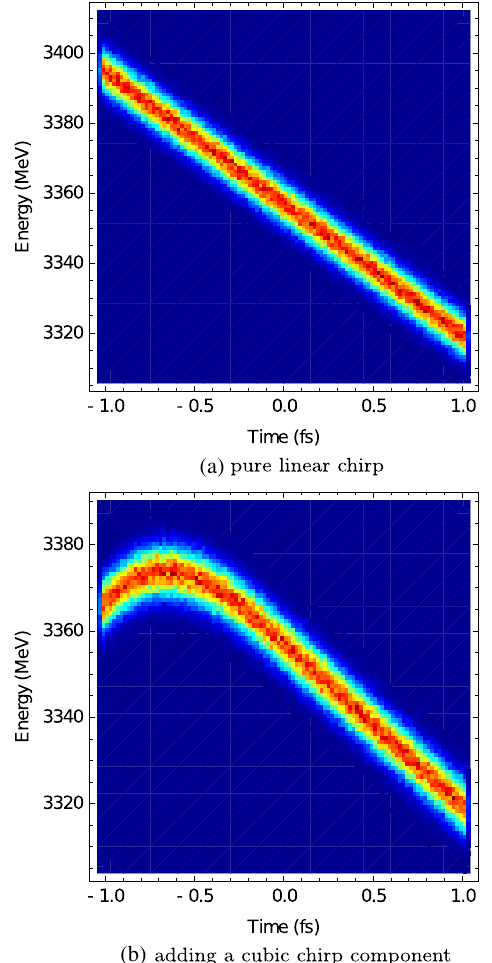
FIG. 7. Chirp profiles of the electron beam used in GENESIS simulations. The upper graph shows the case of a pure linear chirp, while the lower figure shows the phase-space profile after the addition of a cubic chirp component at the head of the beam (left-hand side of the graph). This example is pretty close to the matched case in terms of linear chirp-taper compensation.